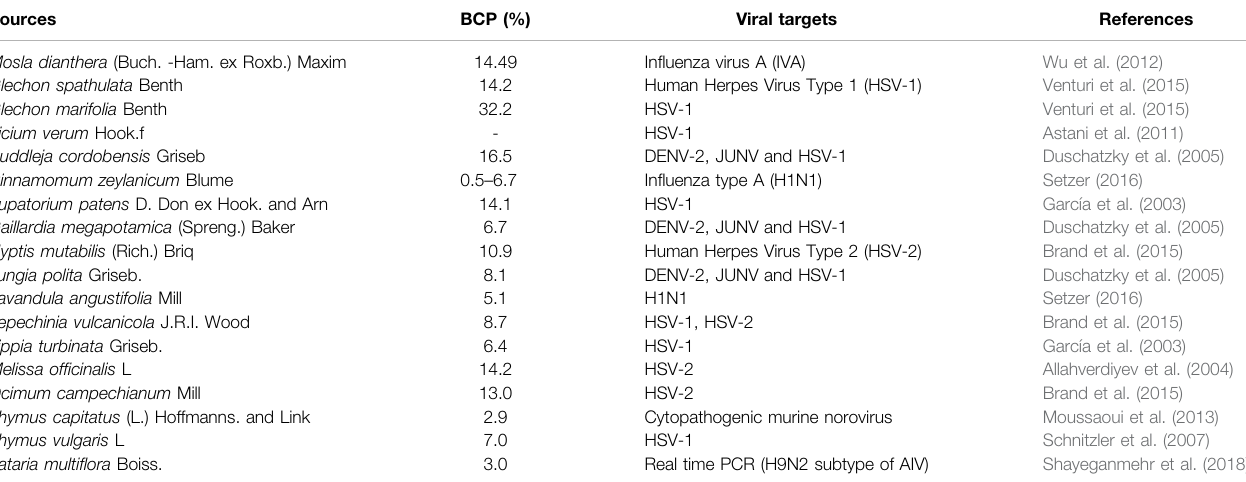
TABLE 1 | The antiviral activities of β -Caryophyllene (BCP) or BCP containing plants. Sources BCP